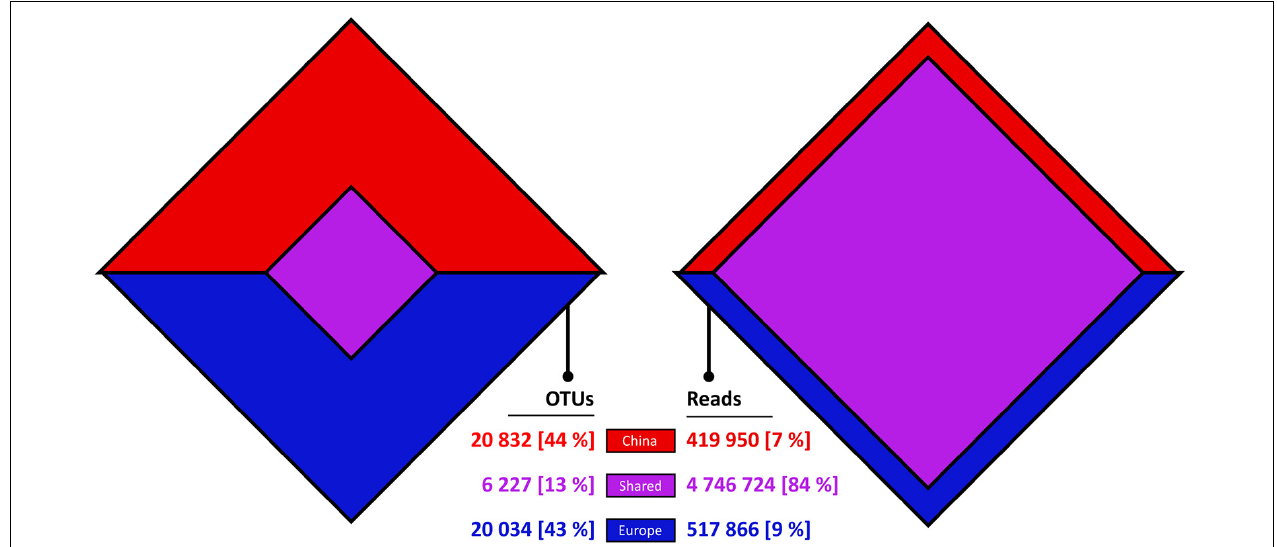
FIGURE 1 | Venn-diamonds displaying the comparison between Chinese, European, and shared Swarm OTUs and their respective read numbers.